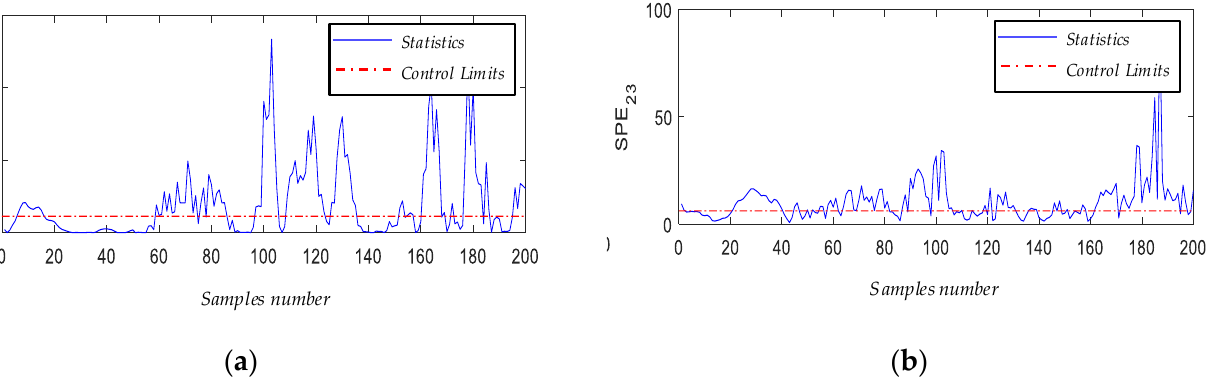
Figure 5. Experimental results of DE-PCA fault detection method for the rolling bearing rolling body: ( a ) the result of T 2 ; ( b ) the result of SPE 23 .